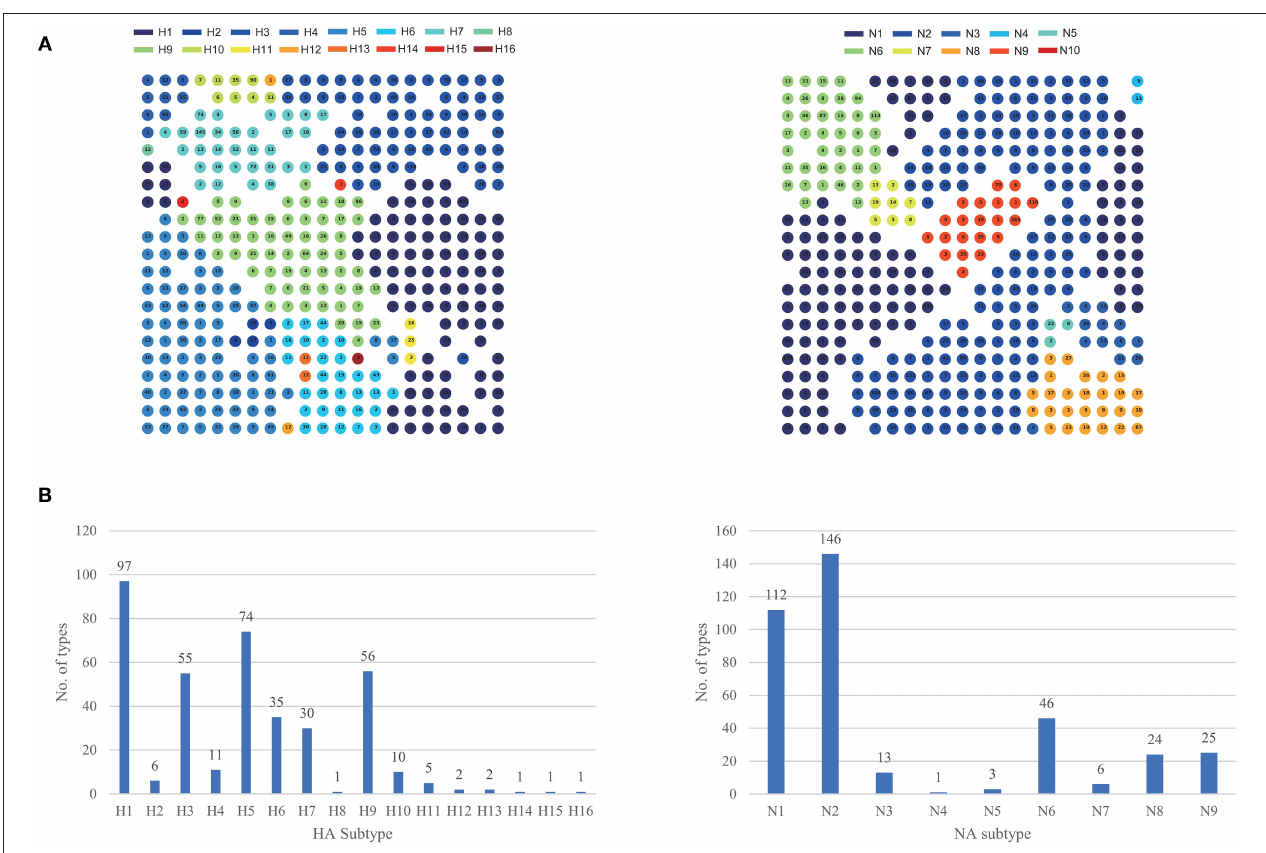
FIGURE 4 | The clustering result for HA and NA segments. (A) The circles represent the clustering types. The number in the circle represents the number of segments contained in the type. Different subtypes are represented by different colors. If a type contains multiple subtypes, the circle will be divided into different parts with different colors. (B) The number of types corresponding to different HA and NA subtypes.